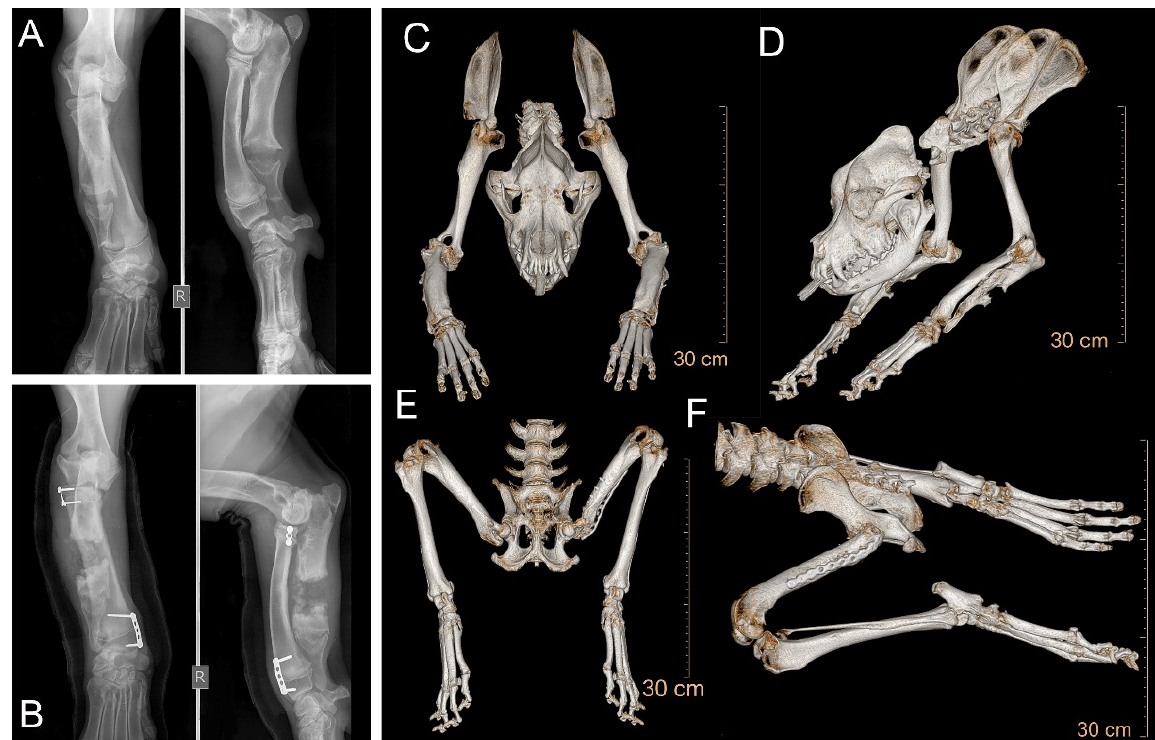
Figure 2. Radiological findings in the affected male dog. ( A ) Orthogonal radiographs of the frontal (left) and sagittal plane (right) of the right forelimb at 3 months of age. Angular deformities represented by shortening of ulna and subsequent bending of the radio causing incongruity of the elbow joint and carpus valgus. ( B ) Radiographs taken after surgical correction at 4 months of age. Evidence of the corrective surgery including ulnar ostectomy in mid diaphysis and presence of plates and screws to close the growth plates of the radius. ( C – F ) Total-body computed tomography at 2 years of age. Three-dimensional multiplanar reconstruction images highlighting the morphology of ( C , D ) skull and forelimbs, and ( E , F ) hindlimbs.